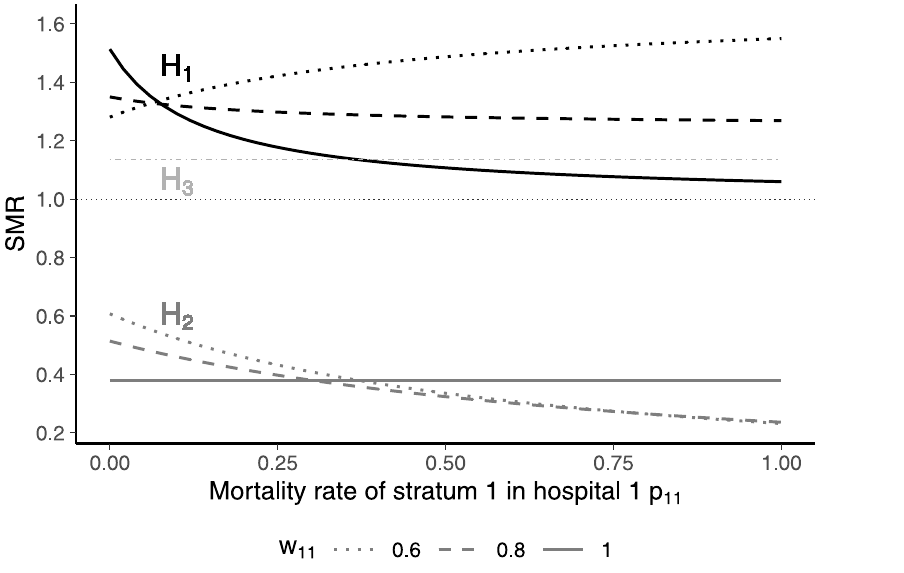
Fig 6. SMRs for different mortality rates p 11 and patient shares w 11 of hospital